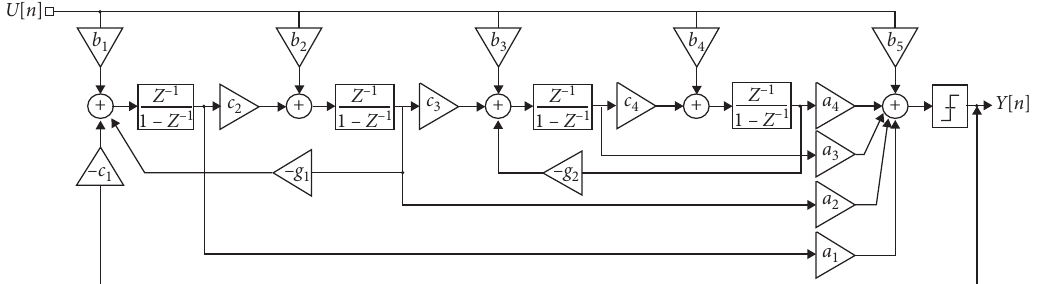
Figure 5: ΔΣ modulator with a cascade of integrator feedforward (CIFF) structure.